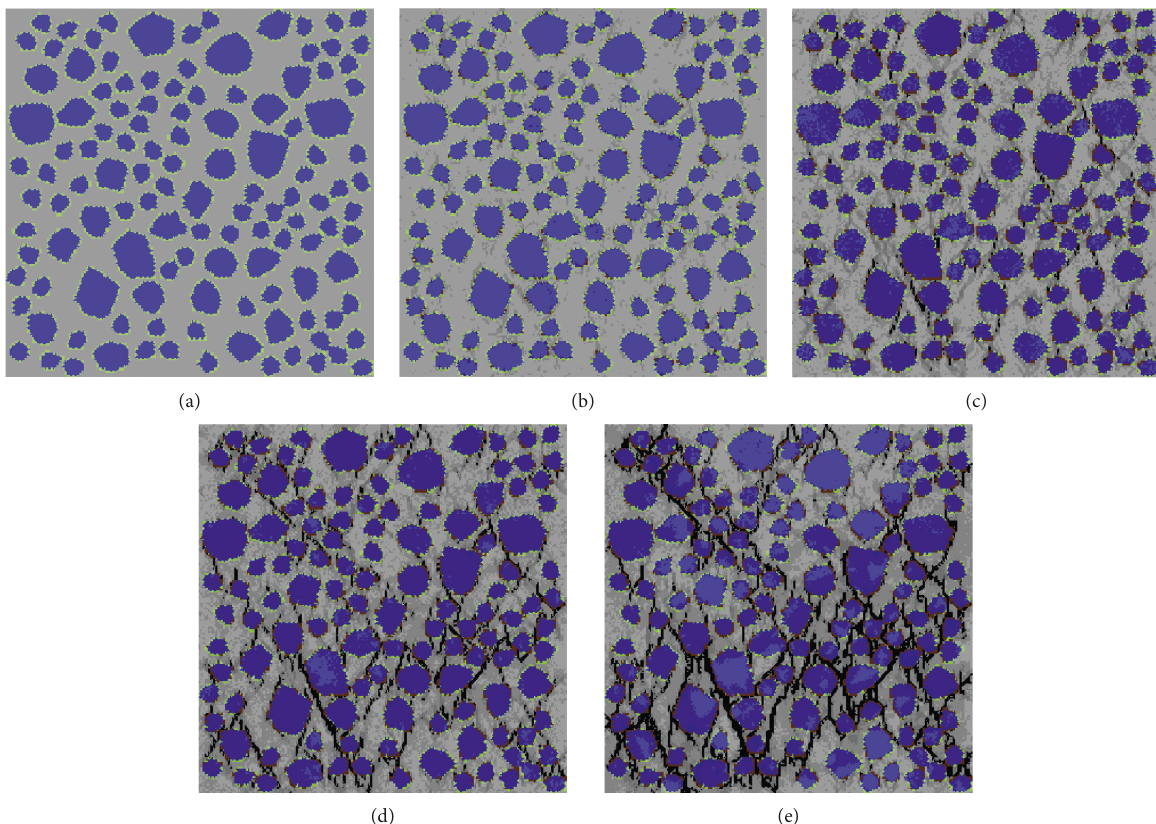
Figure 15: Failure process of concrete under uniaxial